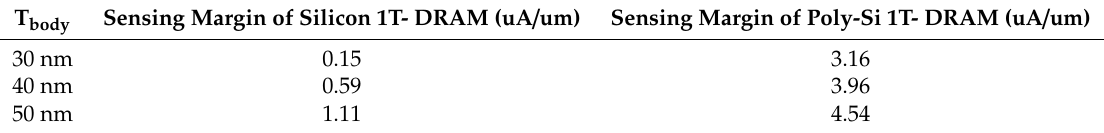
Table 2. Sensing margin of silicon and poly ‐ Si 1T ‐ DRAMs for varied T body.